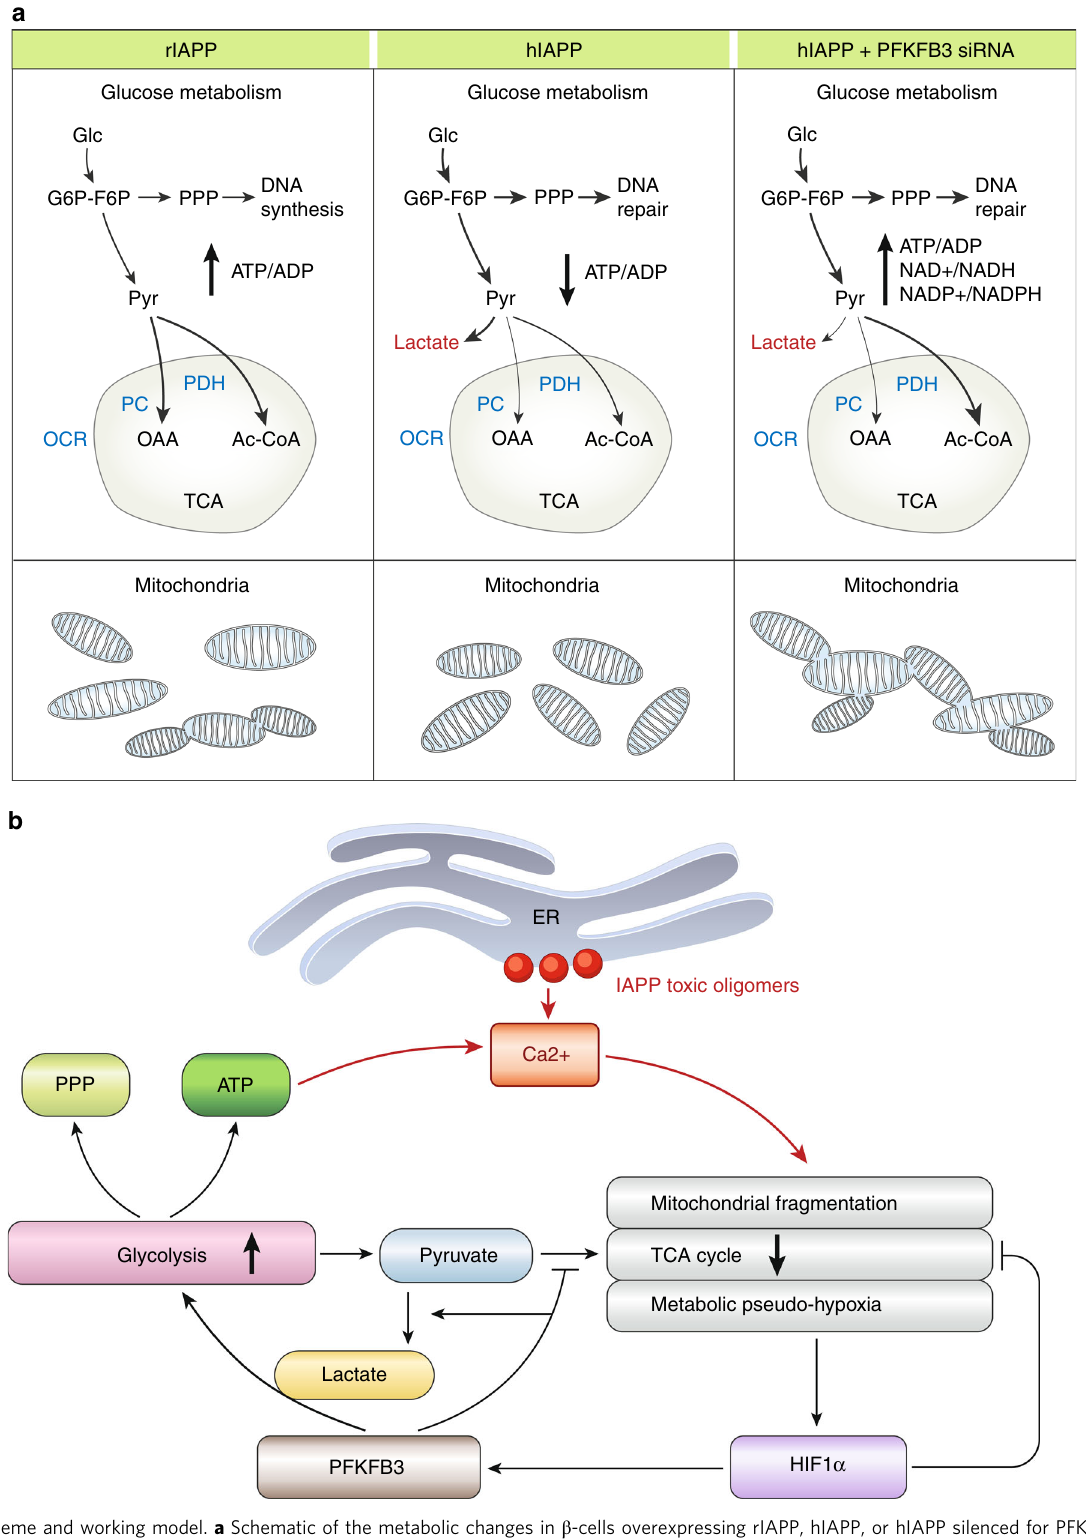
Fig. 10 Scheme and working model. a Schematic of the metabolic changes in β -cells overexpressing rIAPP, hIAPP, or hIAPP silenced for PFKFB3. In comparison with INS 832/13 overexpressing rIAPP, cells transduced with hIAPP show fragmentation of the mitochondrial network and upregulation